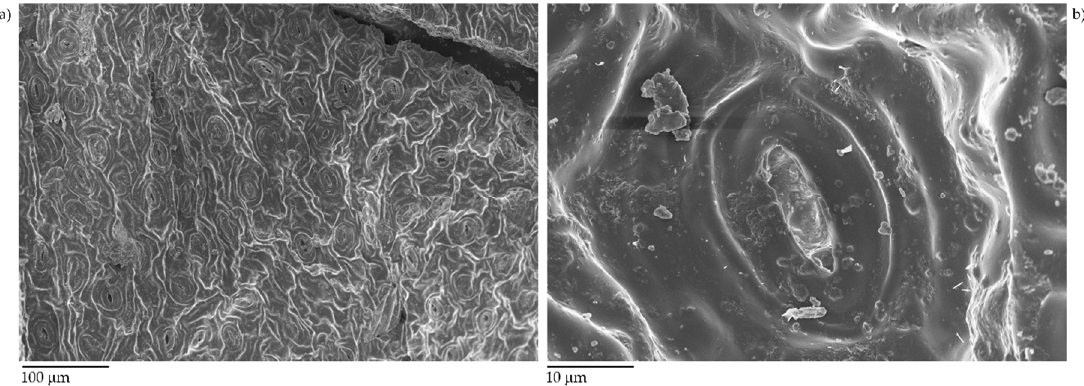
Figure 1. Capture of untreated exhausted tea leaves after metalization with 5 nm layer of chromium with low ( a ) and high ( b ) magnification.